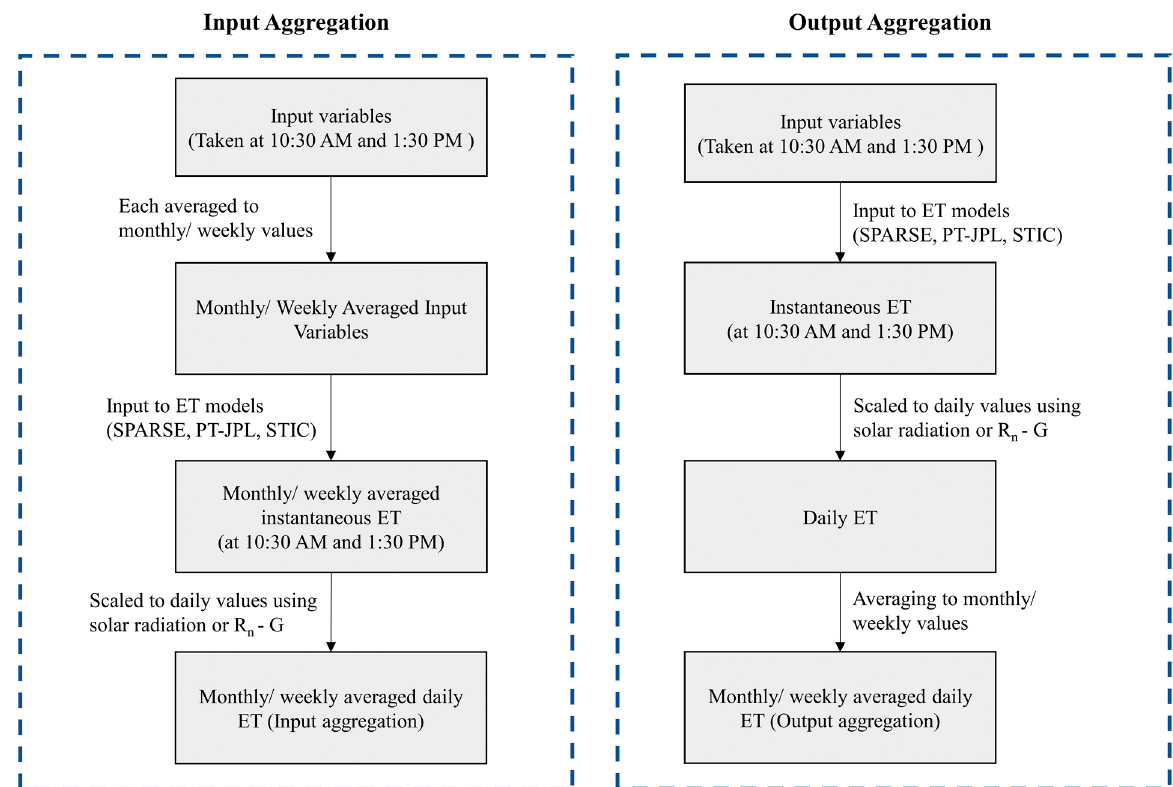
Figure 2. Methodology flowchart.